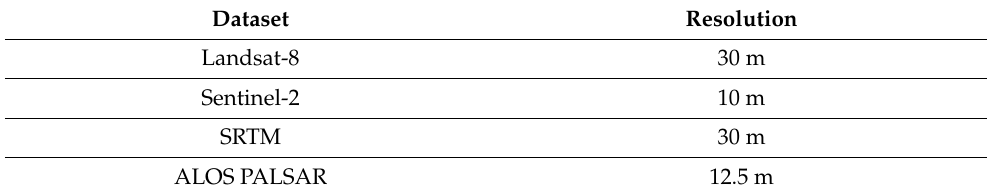
Figure 5. Conditioning factors derived from different DEMs and Landsat 8 and Sentinel-2 satellite images: ( a ) slope, ( b ) aspect, ( c ) plan curvature, ( d ) topographic wetness index (TWI), ( e ) landcover, and ( f ) normalized difference vegetation index (NDVI). Table 1. Satellite data used for this study from the Earth engine data catalog.